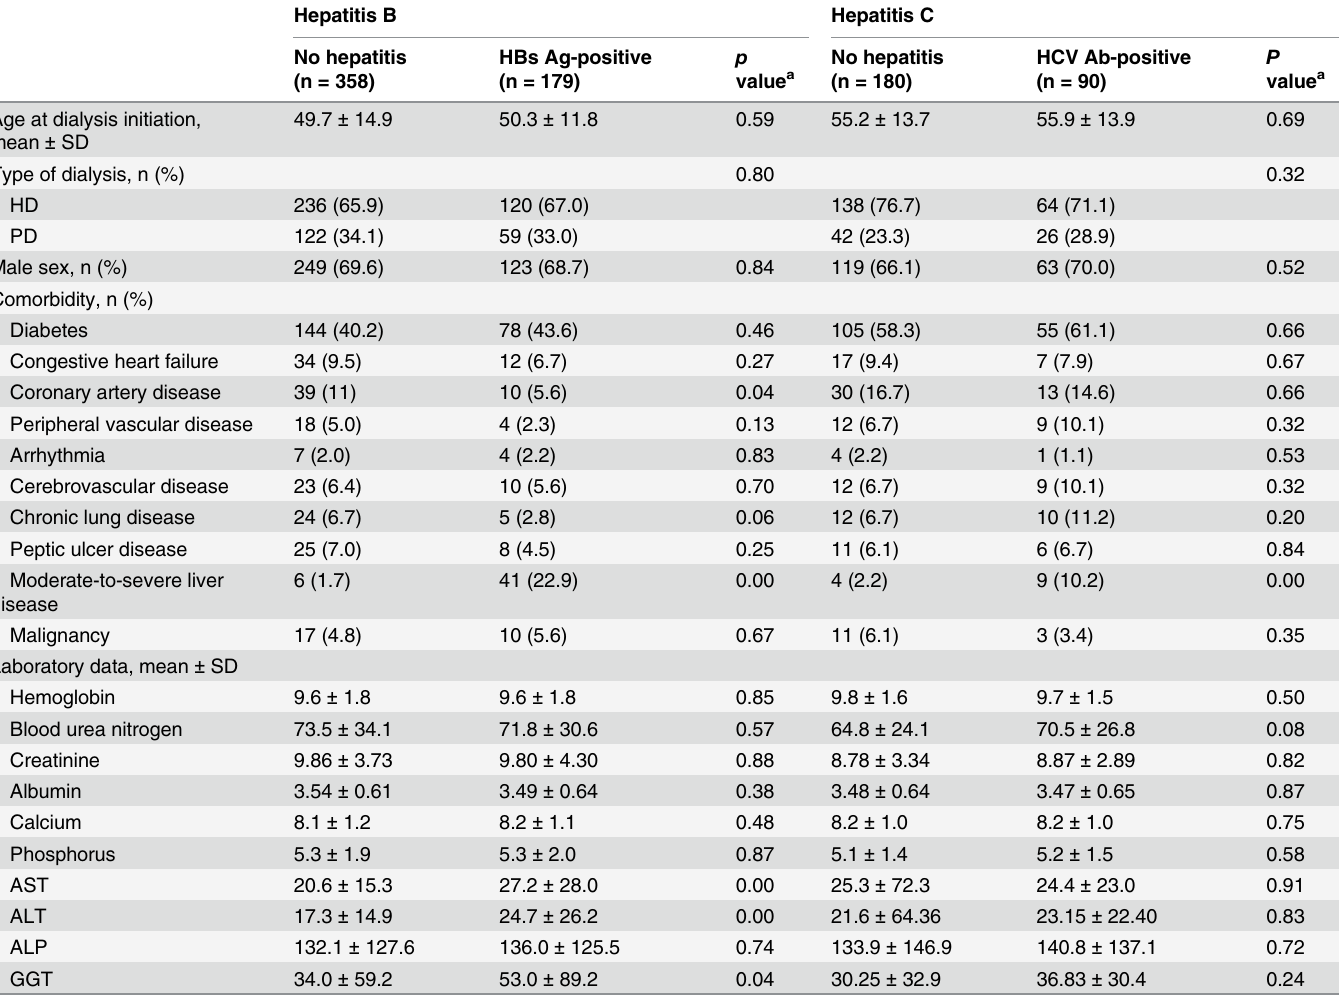
Table 2. Baseline characteristics of propensity score-matched hepatitis B and C